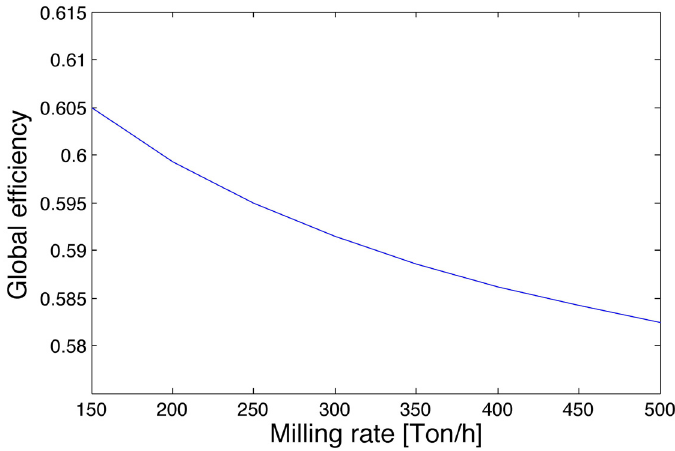
Figure 6. Global efficiency (as defined in Equation 21) of the sugarcane plant as a function of milling